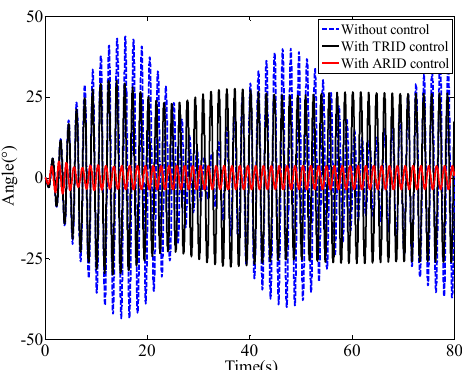
Figure 7. Numerical results of the swing angle of the structure with the TRID or ARID system.